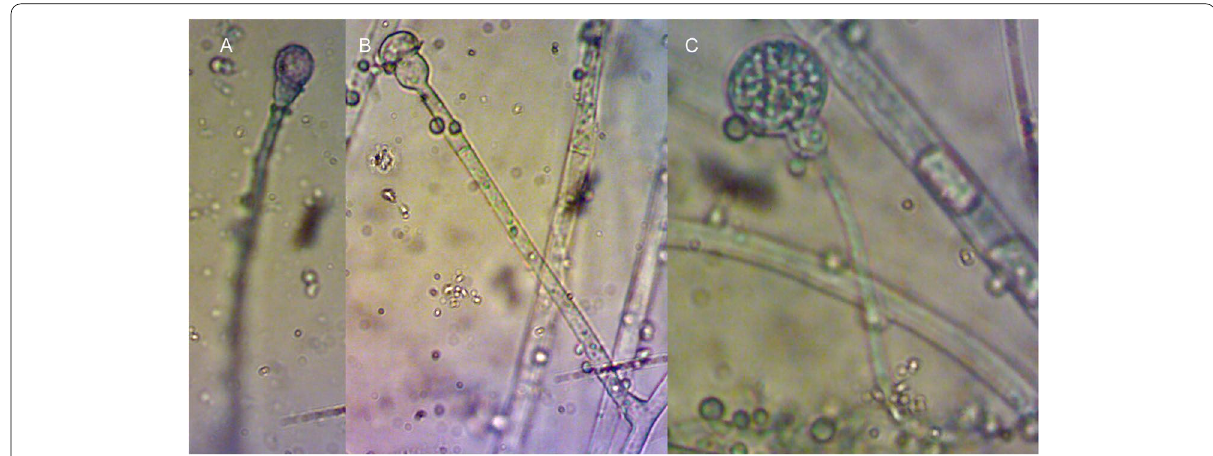
Fig. 2 Sporangial characteristics of G. butleri . A and B Developmental stages. C Mature stage